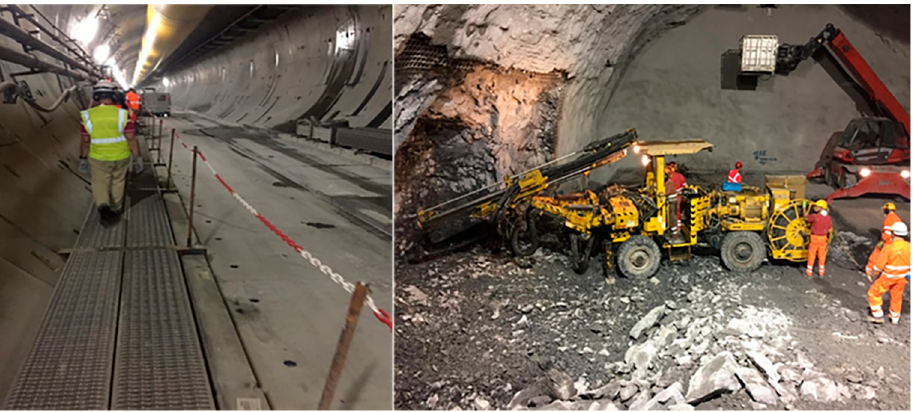
Figure 1. Walkways during tunnel construction with mechanized excavation—TBM (Tunnel Boring Machine) ( left ). Face excavation with drill and blast method, which involves high concentration of machinery ( right ).